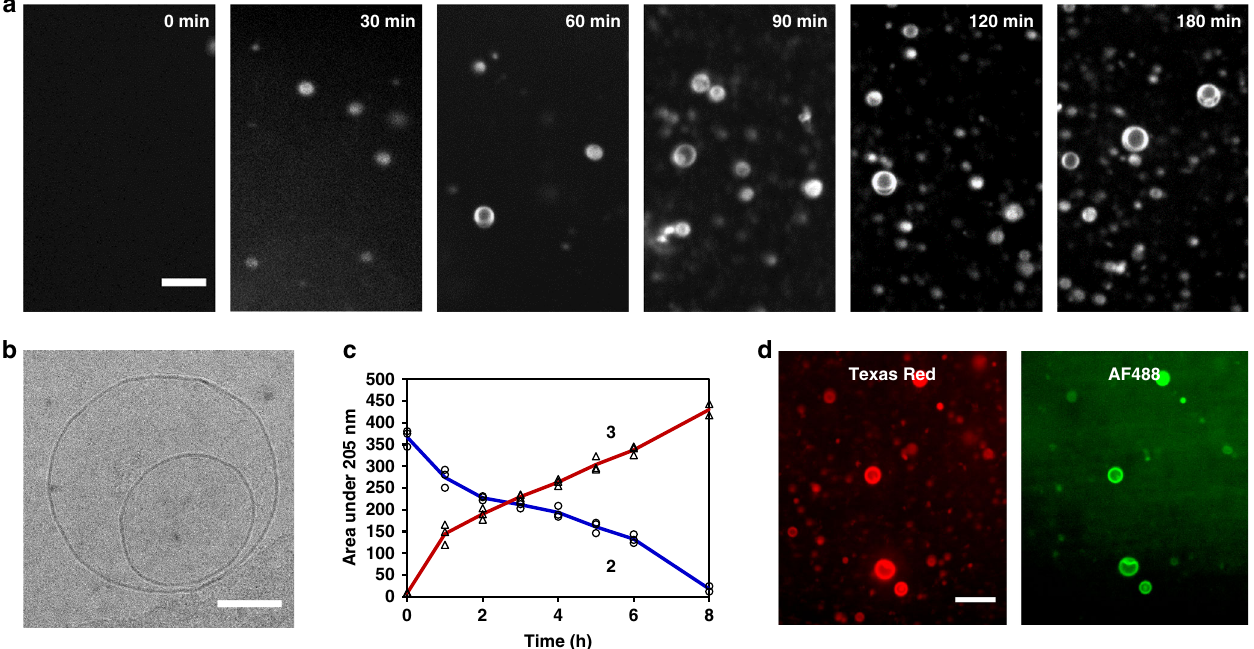
Fig. 2 FadD10 mediated de novo formation and assembly of phospholipid membranes. a Time series of spinning disk confocal microscopy images depicting de novo phospholipid 3 vesicle formation resulting from the incubation of an aqueous solution of dodecanoic acid, lysolipid 2 , ATP, MgCl 2 , FadD10, and 0.1 mol% Texas Red ® DHPE at 37 °C. Scale bar: 10 µ m. b Cryogenic-transmission electron microscopy (cryo-TEM) image of a de novo formed phospholipid vesicle showing the presence of membranes. Scale bar: 100 nm. c Kinetics of the consumption of lysolipid 2 (open black circles, blue line) and formation of phospholipid 3 (open black triangles, red line) at 37 °C. Integrated HPLC peak areas (205 nm) from three experiments were used to monitor the progress of the reaction. d Spinning disk confocal microscopy images of phospholipid 3 vesicles formed with Alexa Fluor ® 488-labeled FadD10 and 0.1 mol% Texas Red ® DHPE, showing association of the enzyme with the membrane. Scale bar: 10 µ